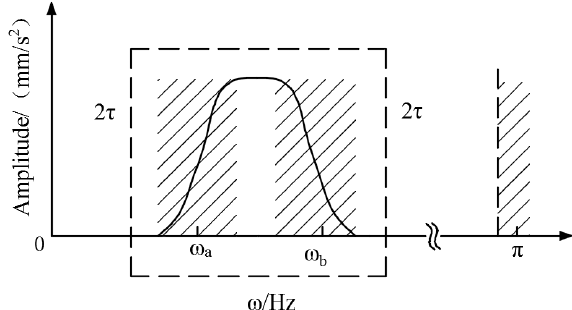
Figure 2. Diagram of empirical wavelet transform (EWT) spectral boundary division with an adaptive frequency window.